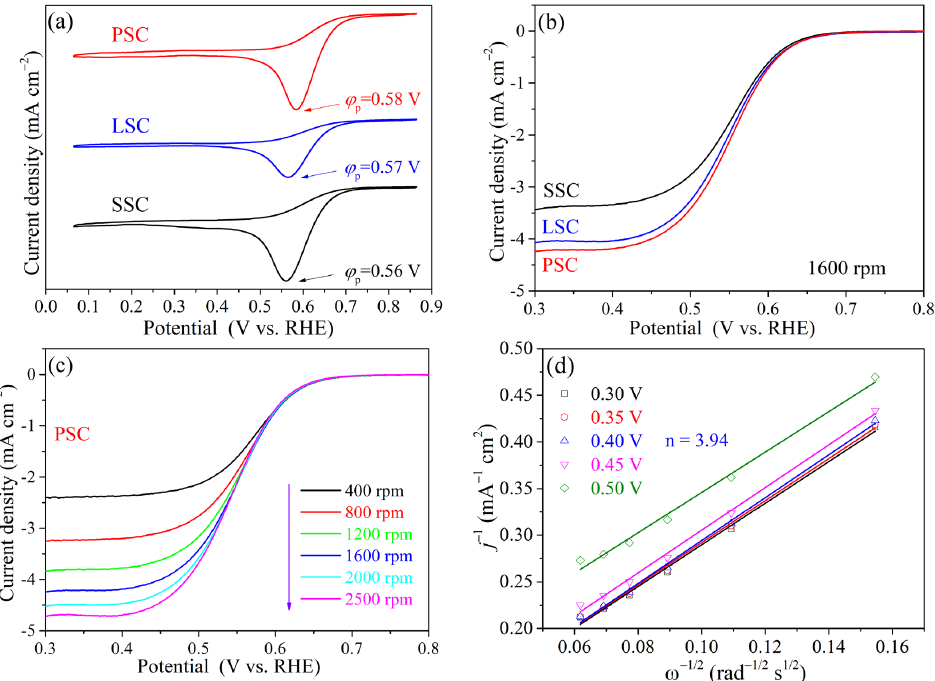
Figure 4 . ( a ) Cyclic voltammetry curves of various samples in O 2 - saturated 0.1 M KOH at a scan rate of 10 mV s −1 ; ( b ) LSV curves for ORR of LSC, PSC and SSC; ( c ) LSV curves of the PSC at various rotating rates from 400 to 2500 rpm; ( d ) K - L plots of PSC at various potentials and the calculated electron transfer number